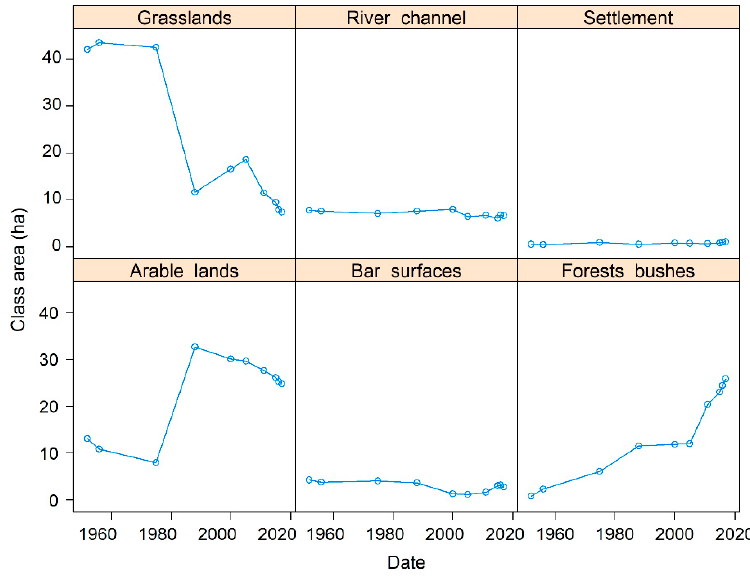
Figure 8. Changes in land cover over the studied period by patch types.